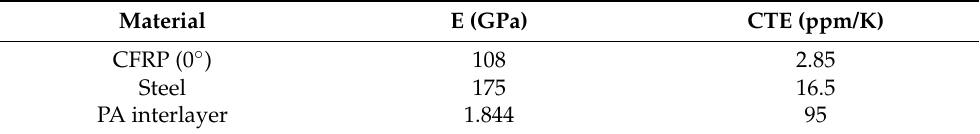
Table 2. Material properties for stress calculation.